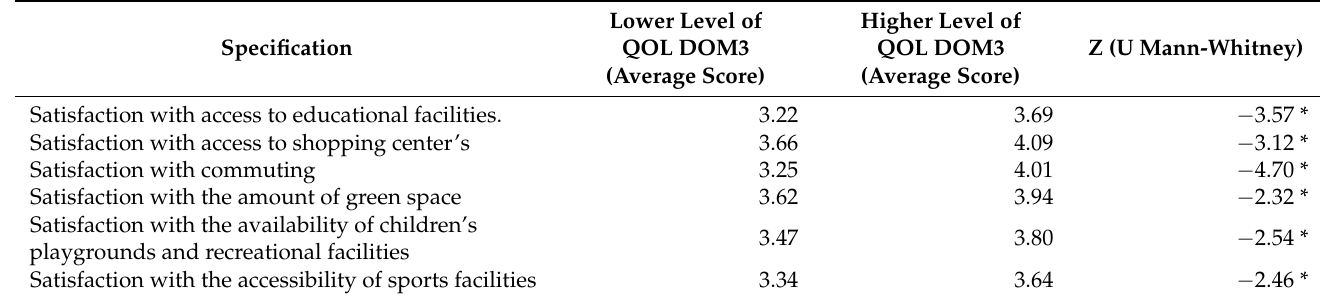
Table 5. Level of satisfaction with selected elements of urban infrastructure concerning the level of quality of life in the social domain (DOM3) (Mann-Whitney U